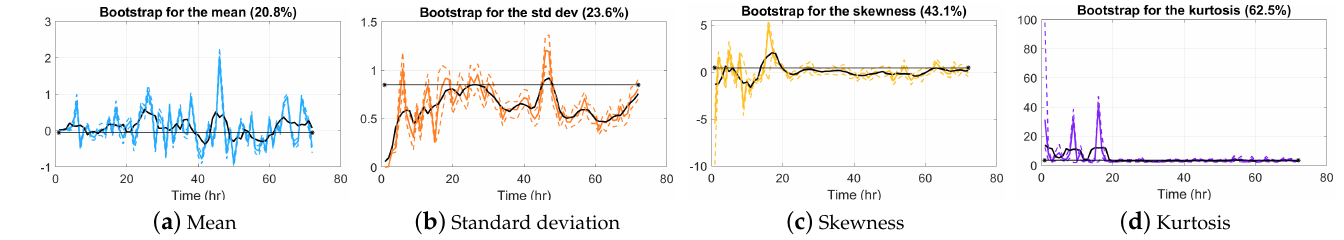
Figure 16. Bootstrap for temperature and its mean ( a ), standard deviation ( b ), skewness ( c ), and kurtosis ( d ), using (cid:101) 1 . Evaluation realized on Barbosa grid. The number given for each bootstrap is the percentage of times the statistic was inside the confidence